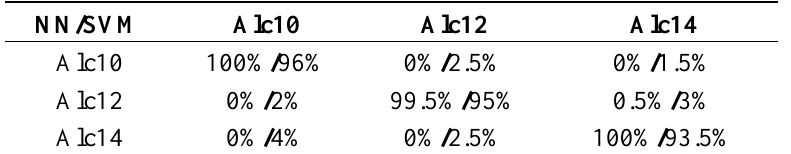
Table 3. Confusion matrix for the neural network (NN) and the